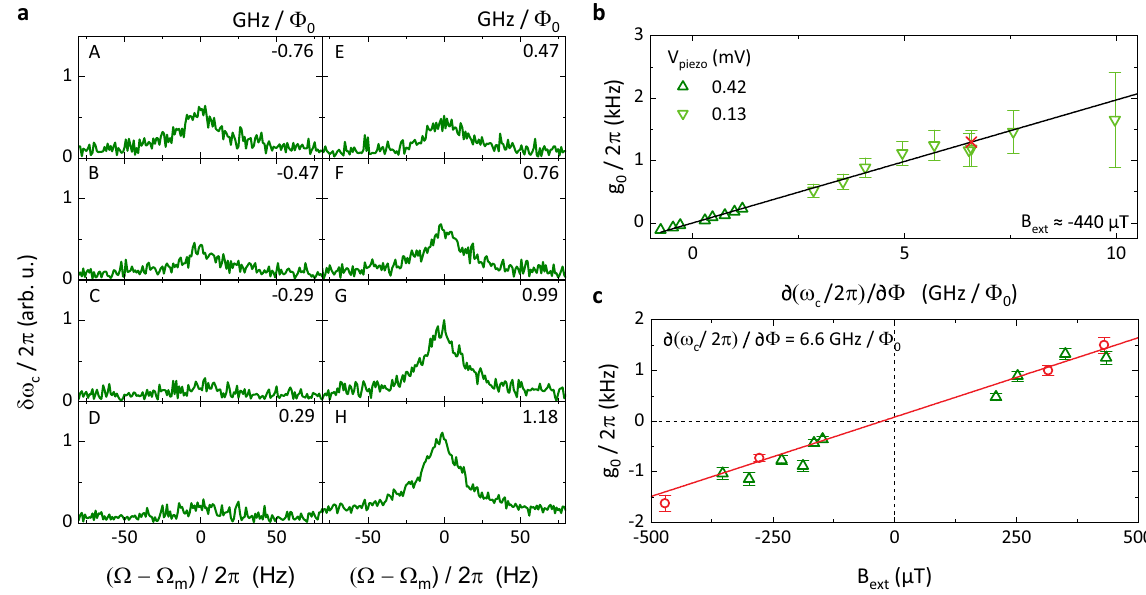
Fig. 4 Scaling of the electromechanical coupling rate at T = 126 mK. Panel a shows the mechanically driven resonator shift δω c close to Ω m for a coherent mechanical drive at angular frequency Ω generated by a piezo actuator for the various operation points labeled in Fig. 2. The external static magnetic fi eld is set to B ext ≈ − 440 μ T. At magnetic fi eld bias points (e.g., C, D) with low fl ux responsivity, almost no mechanical signature is observed, in contrast to those points (E to H) with large fl ux responsivity. Panel b displays the electromechanical coupling rate g 0 deduced from the response in panel ( a ). The derived values are plotted versus the fl ux responsivity for low (light green triangles) and high piezo drive amplitudes (dark green triangles), and are linked to the thermal displacement measurements (red cross). This data con fi rms the linear scaling of the electromechanical coupling strength with ∂ ω c / ∂ Φ . In panel c , we plot the coupling rate g 0 obtained both from driven (green) and thermal displacement measurements (red) versus the applied magnetic fi eld B ext for a fi xed fl ux responsivity of ∂ ( ω π )/ ∂ Φ = 6.6 GHz/ Φ fi guration, the external fi eld sets the working point of the microwave c /2 0 . In the given experimental con resonator. As fl ux jumps occurred during the experiments the recorded driven measurements could not be performed at identical fi eld bias as the thermal ones. The error bars on the data in panels ( b ) and ( c ) include the standard error originating from the model- fi t to the data and errors originating from the calibration. If not shown, error bars are smaller than the symbol